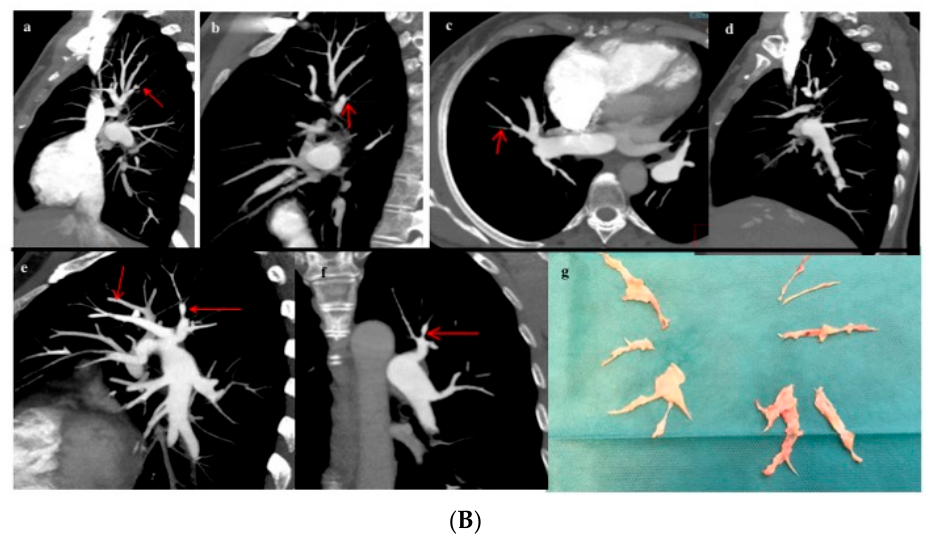
Figure 5. Patient with proximal CTEPH ( A ). ( a , b ) Rectified interventricular septum (red thin arrow) and reduction of venous return (*). ( c – e ) Thromboembolic disease affecting the main pulmonary artery (red thick arrow) with extension to the right upper lobar artery (arrowhead). ( f ) Surgical specimen showing level I disease. Patient with distal CTEPH ( B ). ( a – f ) Organized intravascular material (thin red arrows) is identified at distal-segmental /subsegmental levels in all the pulmonary lobes. ( g ) Surgical specimen showing level III disease. Table 1. Intraoperative CTEPH classification of intervened patients regarding initial operability assessment. Surgical CTEPH Classification